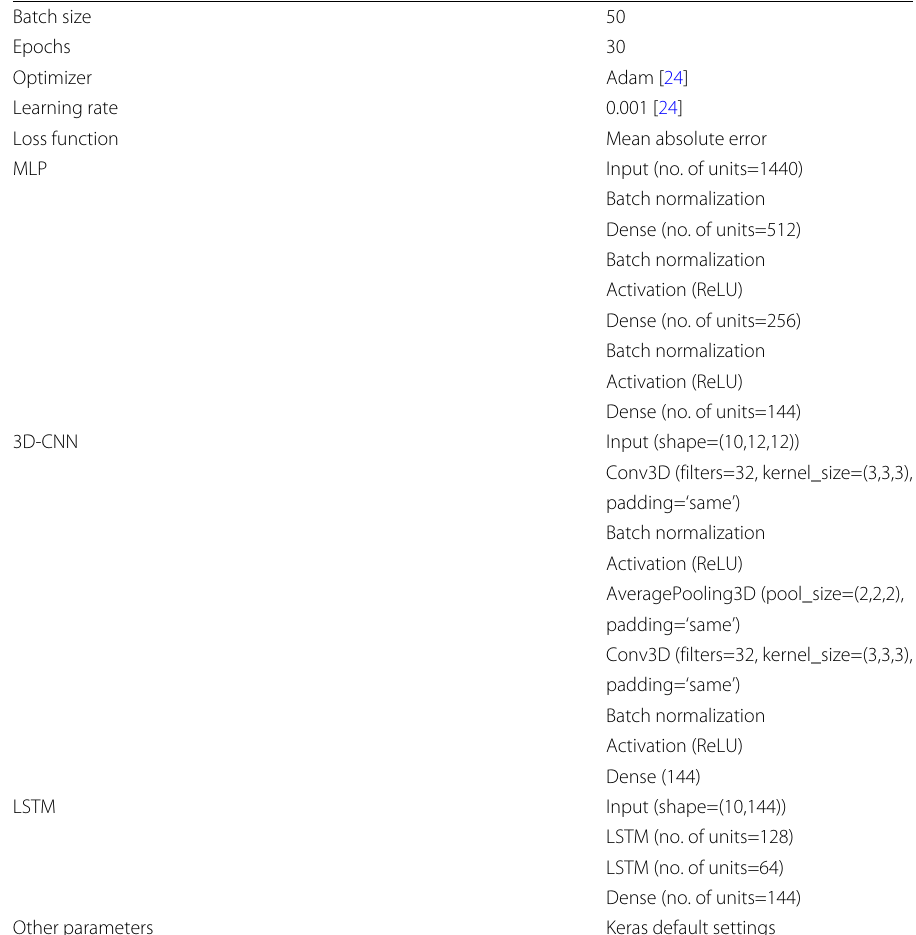
Table 1 Parameter settings for neural-network-based methods Batch